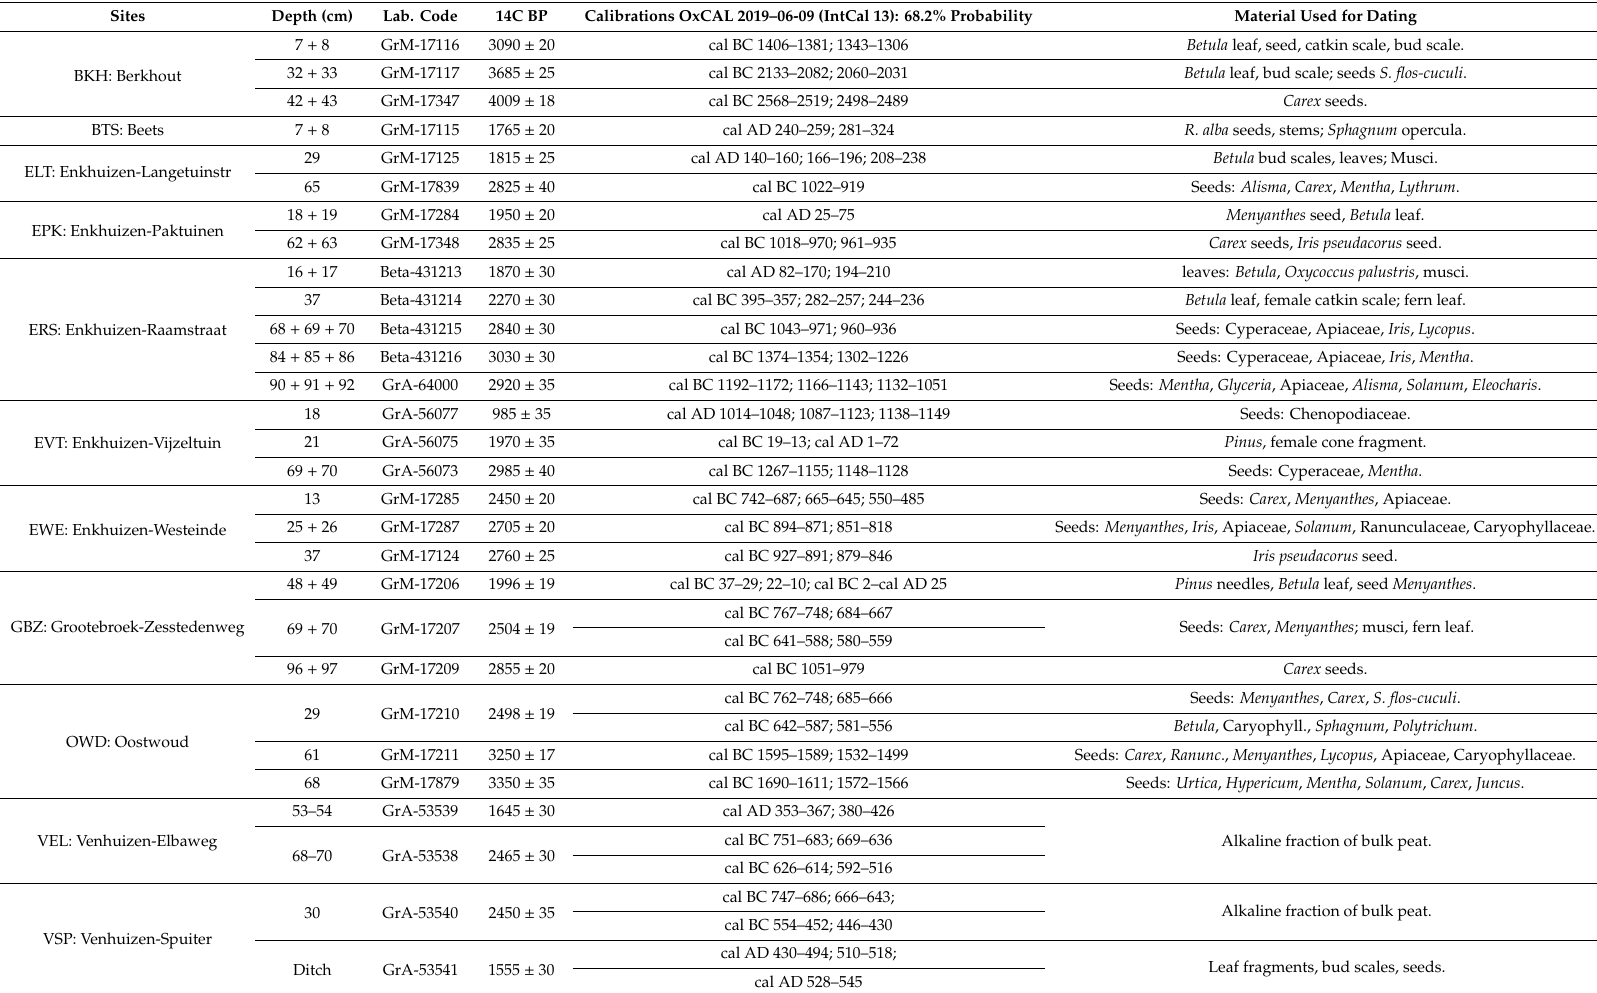
Table 3. Radiocarbon dates and calibration results of samples from the studied West-Frisian sequences. GrM and GrA samples were dated by the Centre for Isotope Research, Groningen and Beta samples by the radiocarbon laboratory of Beta Analytic, London,